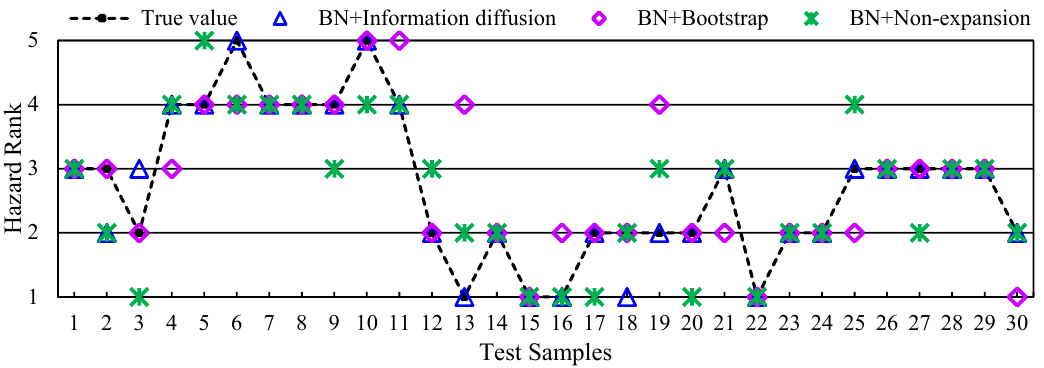
Figure 5. Assessment results of testing samples.